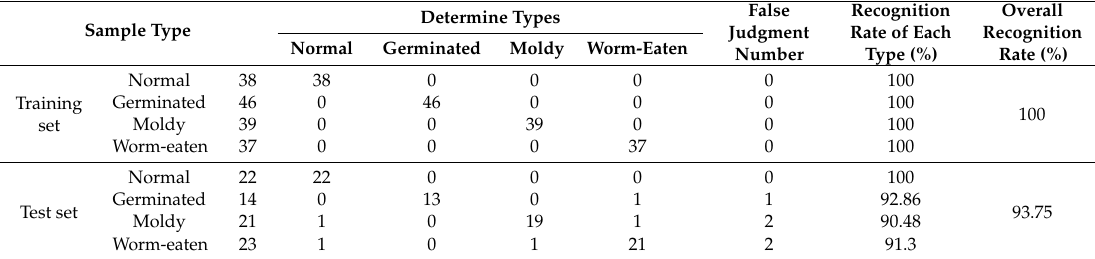
Table 3. Modeling results of Linear SVM wheat classification fusion